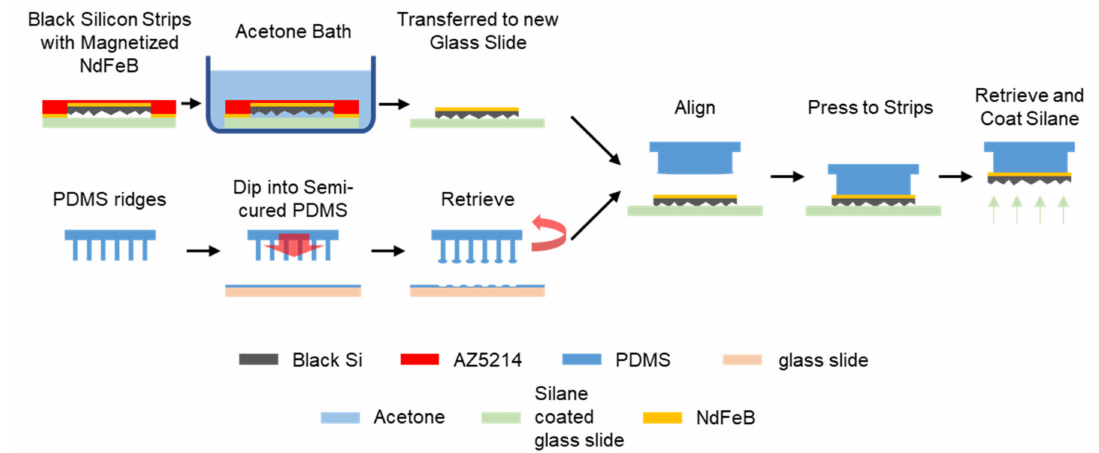
Figure 4. Transfer printing of the black silicon strips to the array of elastomer ridges.